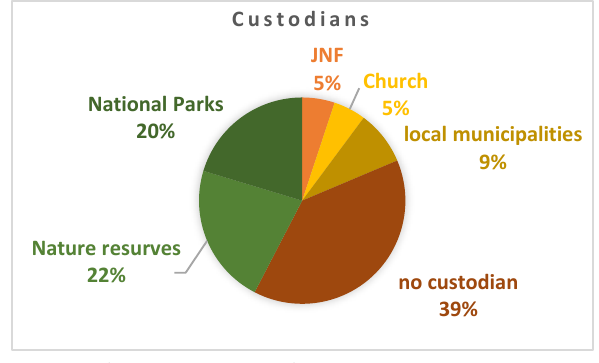
fig. 4. Distribution of custodians. 2. A survey of archaeological sites included in The National Master Plan for Forests and Afforestation all over the country, looked at management aspects and potential sites for conservation as part of development plans for forests (see fig. 5).